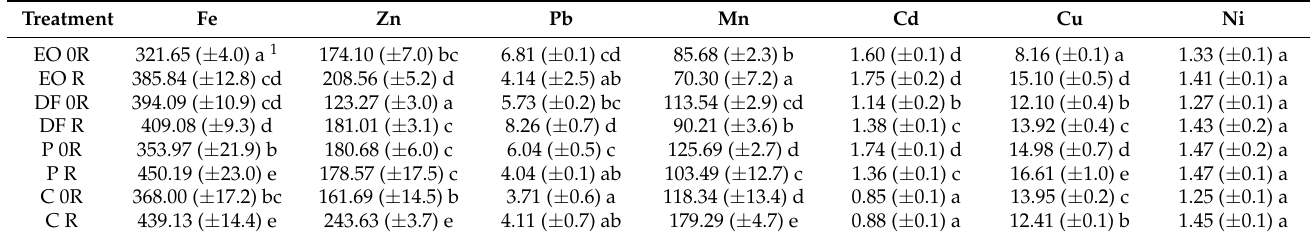
Table 7. The effect of PDSs and bioremediation on the content of the selected microelements and heavy metals in the leaves of Vicia faba L. (mg kg − 1 ).